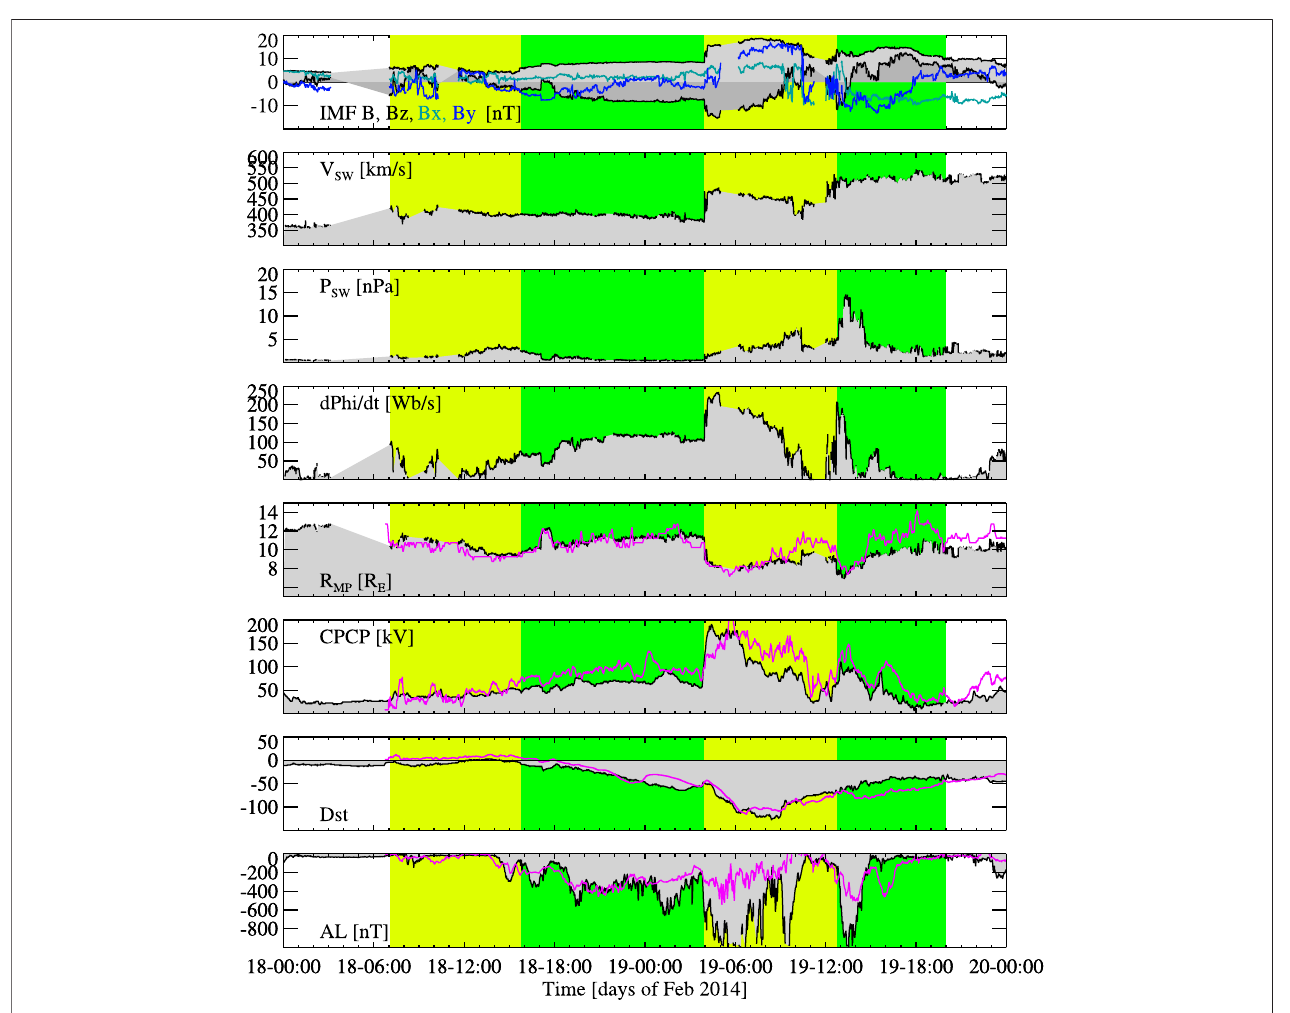
FIGURE 1 | Observations of the solar wind driver and magnetospheric response (black line with shading) compared with SWMF Geospace results (magenta line). Fromtoptobottom:IMFX(green),Y(blue)Z(black)components,total fi eldmagnitude(black);solarwindspeed;solarwindpressure,Newellcouplingfunction(seetext); Magnetopause standoff distance (see text); cross-polar cap potential (see text); SMR (SuperMAG SYM-H index); SML (SuperMAG AL index). The yellow and green shading indicate the ICME sheath and ejecta respectively. The magenta lines in the bottom four panels show the SWMF Geospace simulation results.